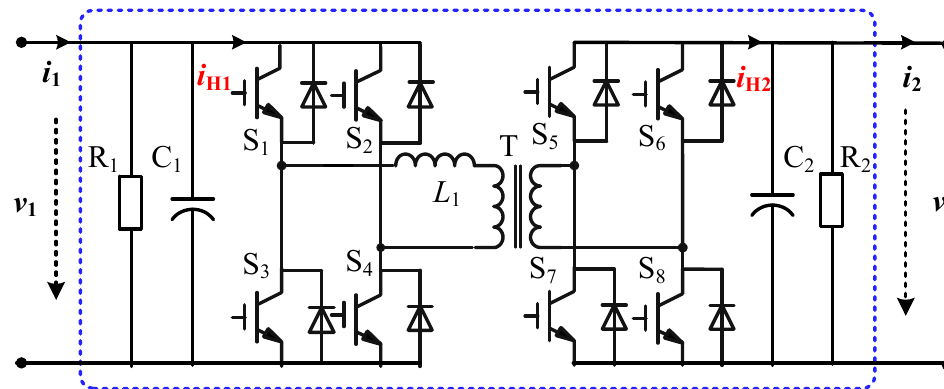
Figure 1. The DAB topology.